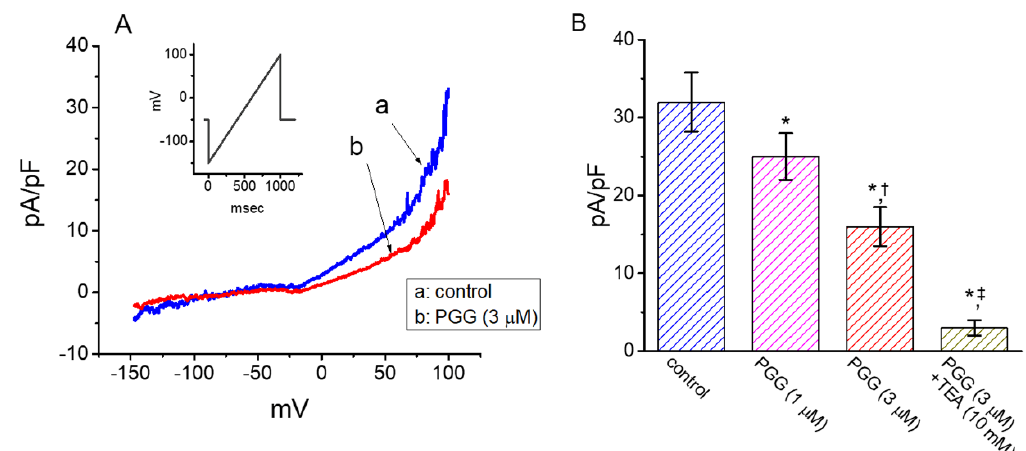
Figure 9. Inhibitory e ff ectiveness of PGG in the density of ramp voltage-induced I K(DR) recorded from human cardiac myocytes (HCM). In this set of whole-cell current recordings, we kept HCM in Ca 2 + -free Tyrode’s solution and then filled up the electrode by using K + -enriched solution. ( A ) Ramp-induced I K(DR) density obtained in the absence (a) or presence of 3 µ M PGG (b). The inset indicates the linear ramp protocol delivered to the cell. ( B ) Summary bar graph showing e ff ect of PGG and PGG plus tetraethylammonium chloride (TEA) on I K(DR) density in HCM (mean ± SEM; n = 8 for each bar). Current density was measured at the level of + 100 mV. The statistical analyses were done by ANOVA-1, p < 0.05, followed by post-hoc Fisher’s least-significant di ff erence test, p < 0.05. * indicates a significant di ff erence from control ( p < 0.05), † indicates a significant di ff erence from the PGG (1 µ M)-alone group ( p < 0.05), and ‡ indicates a significant di ff erence from the PGG (3 µ M)-alone group ( p < 0.05).